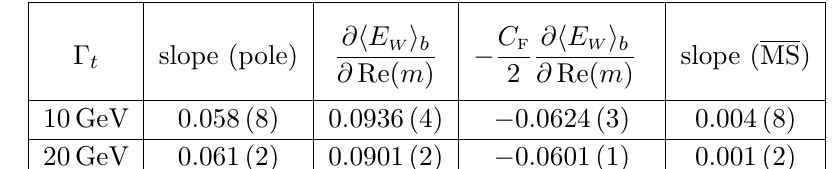
Table 1 . Slopes for e T ( (cid:21) ) computed for h E needed to change to the MS one, for large top